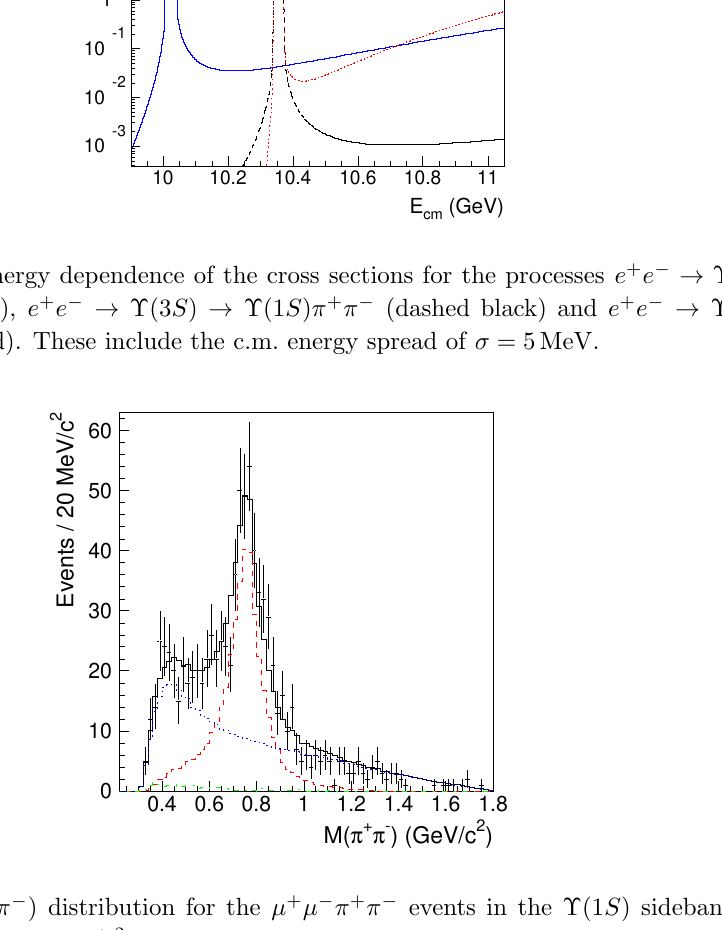
Figure 8 . The M ( (cid:25) + (cid:25) (cid:0) ) distribution for the (cid:22) + (cid:22) (cid:0) (cid:25) + (cid:25) (cid:0) events in the (cid:7)(1 S ) sideband region 8 : 7 < M recoil ( (cid:25) + (cid:25) (cid:0) ) < 9 : 4 GeV =c 2 at E c : m : = 10 : 52 GeV. Points with error bars show data, the histograms show MC simulations of the total QED background (solid black) and various background components: (cid:22) + (cid:22) (cid:0) (cid:25) + (cid:25) (cid:0) (dashed red), misidenti(cid:12)ed 4 (cid:22) (dotted blue), and misidenti(cid:12)ed e + e (cid:0) (cid:22) + (cid:22) (cid:0) (dash-dotted